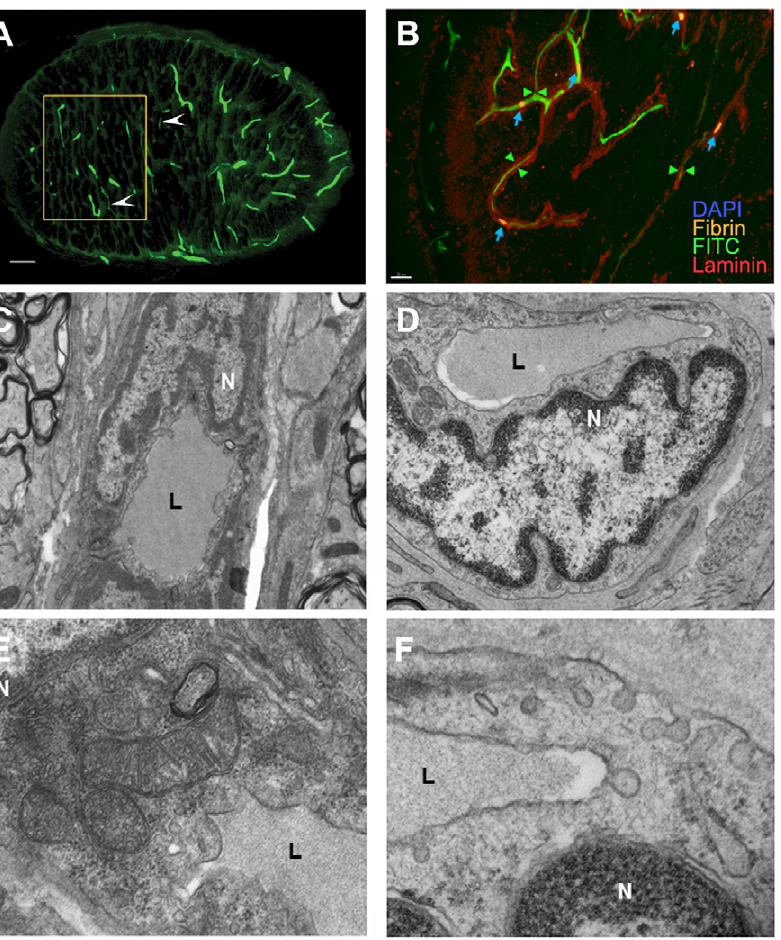
Figure 3. Immunohistochemical and ultrastructural analysis of vascular damage following ON infarct. A–D: Immunohistochemical imaging of vessel and luminal changes. A. FITC-BSA filling of ON 1 day post-infarct. There is general loss of capillary filling. Thinned areas of capillaries are indicated by arrowheads. The area analyzed ultrastructurally (by TEM, panels D and F) is indicated by the rectangle. There is incomplete filling of the capillary bed, compared with naı¨ve controls. B. Immunohistochemical analysis of capillary changes 1 day post-infarct. Immunostaining with laminin (red) and fibrin (orange). FITC-BSA vascular filling (green) is incomplete, with occasional small fibrin-fibrinogen thrombi (indicated by blue arrows) present in the capillaries, which co-localize with reduced and absent areas of capillary patency. C–F: ultrastructural analysis using TEM. C. Naı¨ve ON capillary, magnification 4400 6 . An endothelial cell nucleus (N) is adjacent to the capillary lumen (L). D. ON capillary 1 day post-induction, magnification 4400 6 . The endothelial cell nucleus (N) is lobulated and enlarged, and protruding into the lumen (L), which is reduced in diameter. E. Naı¨ve ON capillary, magnification 15000 6 . Mitochondria are intact and there are small vacuoles in the endothelial cytoplasm, adjacent to the lumen (L). The nucleus (N) is normal in appearance. F. ON capillary 1 day post-induction, magnification 15000 6 . The endothelial cell nucleus (N) has changed appearance. Large cytoplasmic vacuoles, emptying on both sides of the cell membrane, suggest enhanced fluid transit from the lumen and increased extracellular fluid. Scale bars: A. 50 microns. B. 10 microns.C,D. E,F. Figure 3C with 3D). At high magnification, the naı¨ve ON capillary shows intact mitochondria and the presence of small vacuoles (Figure 3E). In comparison, vacuoles fusing with the cytoplasmic membrane are consistently present in the cytoplasm of rAION- induced endothelial cells (Figure 3F), which communicates with both the lumen and extracellular basement membrane surfaces.